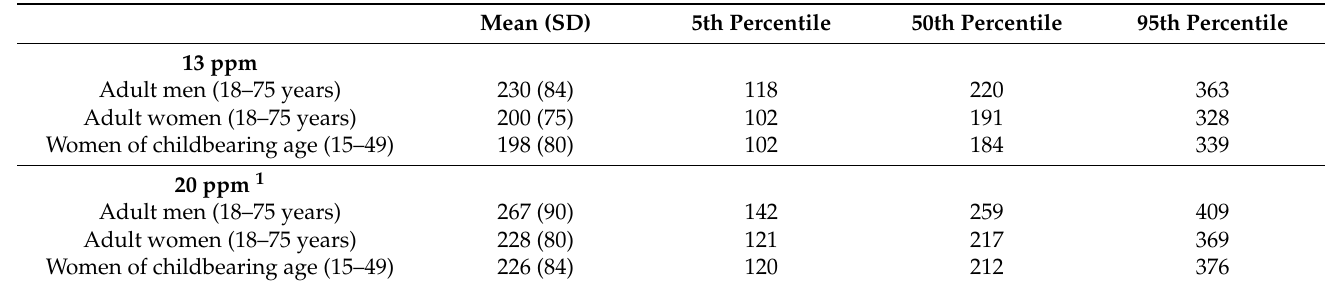
Table 3. Dietary exposure of iodine in µ g/day in the general Danish population at 13 and 20 ppm fortification levels simulated based on the Danish National Survey of Diet and Physical Activity,